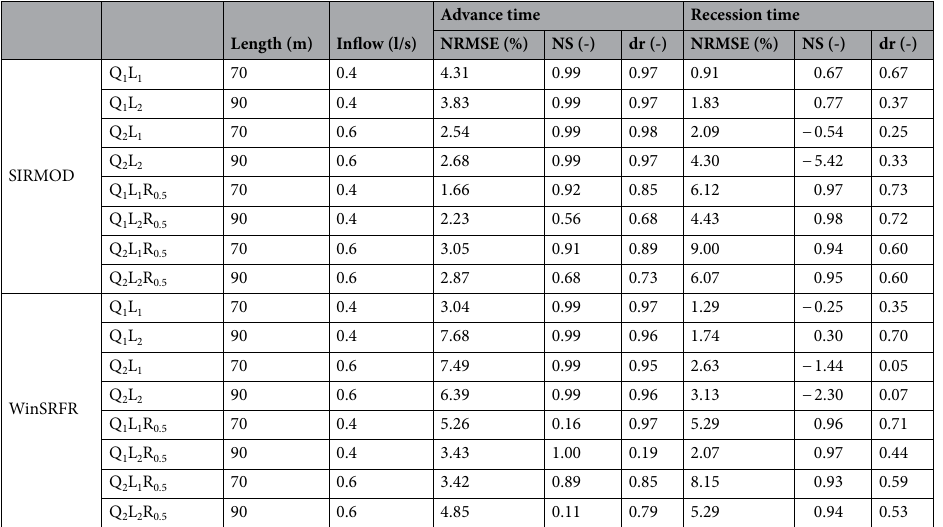
Table 5. Evaluation of the advance-recession times by the SIRMOD and WinSRFR models under the continuous and surge irrigations based on the statistical indicators. Q: stream size; L: furrow length; R 0.5 : surge irrigation with cycle ratio of